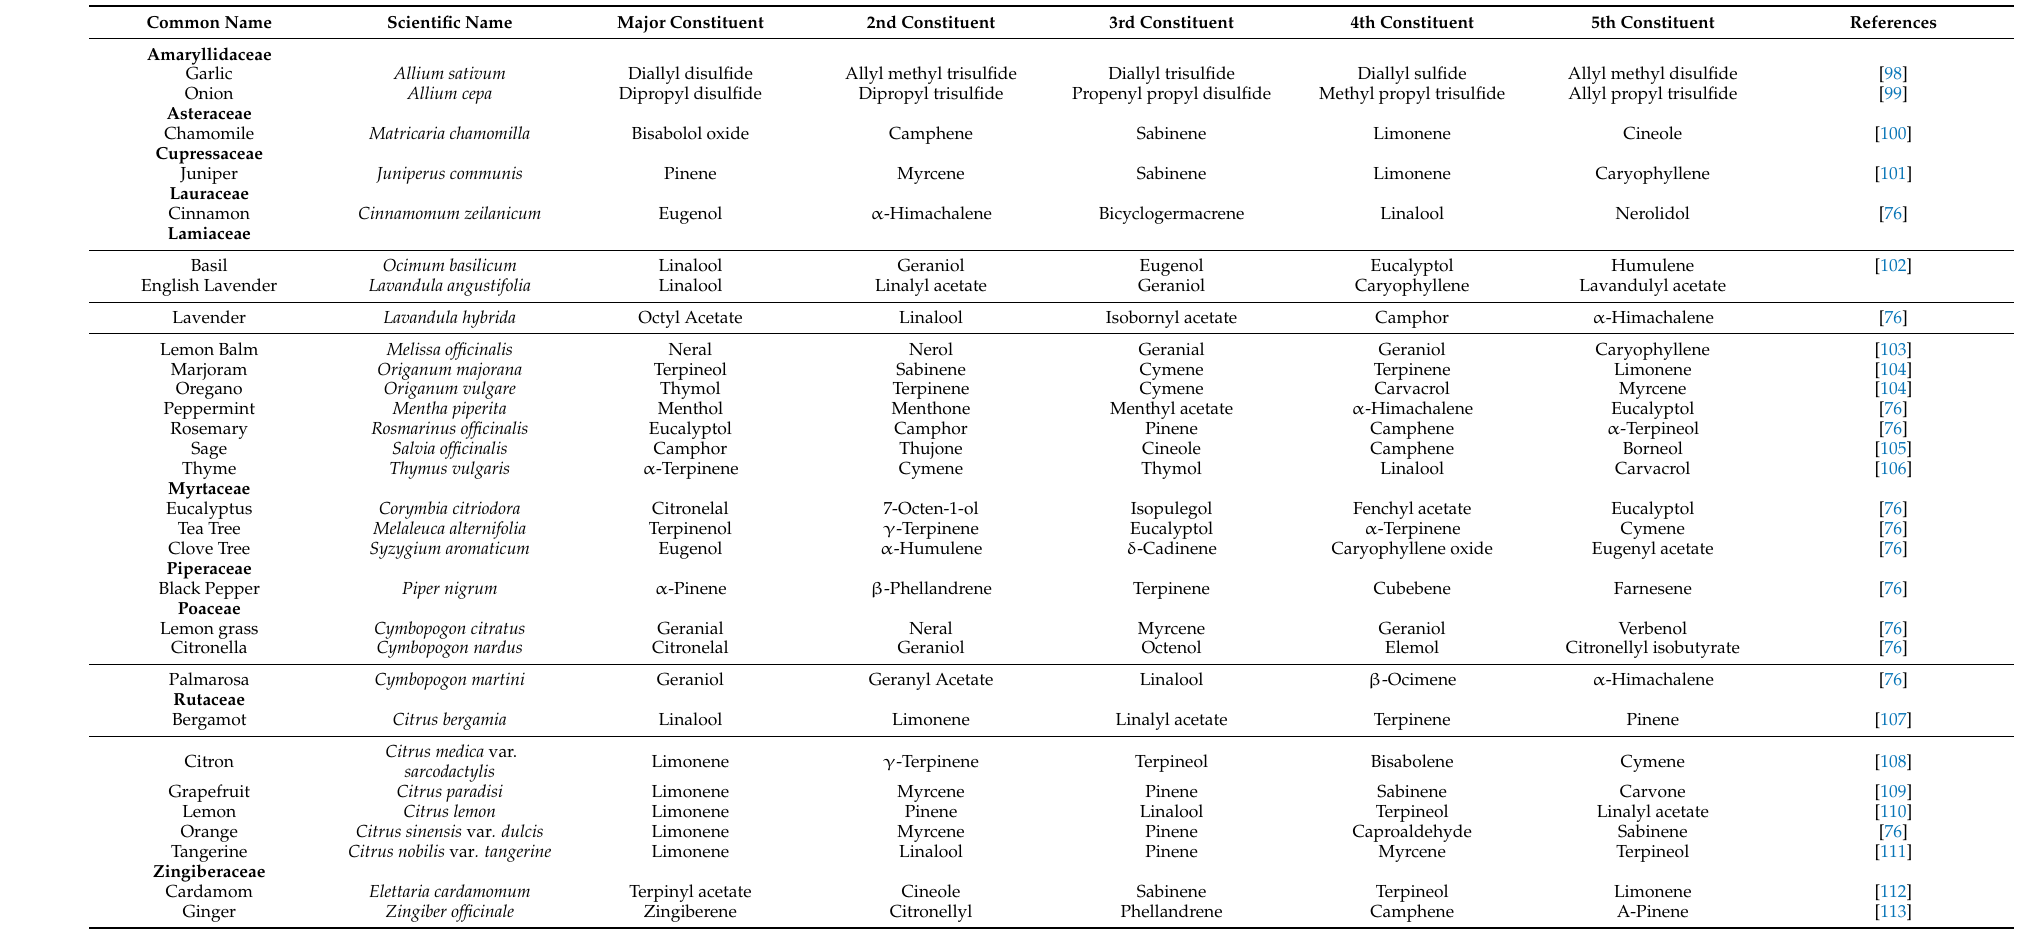
Table 1. Major components of some essential oils with food